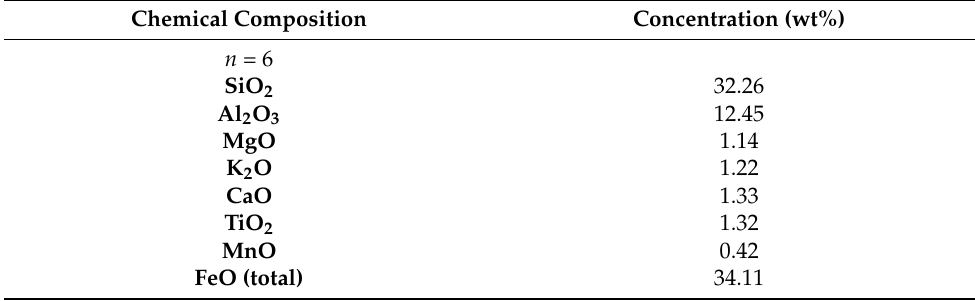
Table 4. Chemical composition (wt%) of glass in SV 1-A determined by scanning electron microscopy (SEM) with Energy dispersive X-ray spectroscopy (EDS) analysis. n = number of data